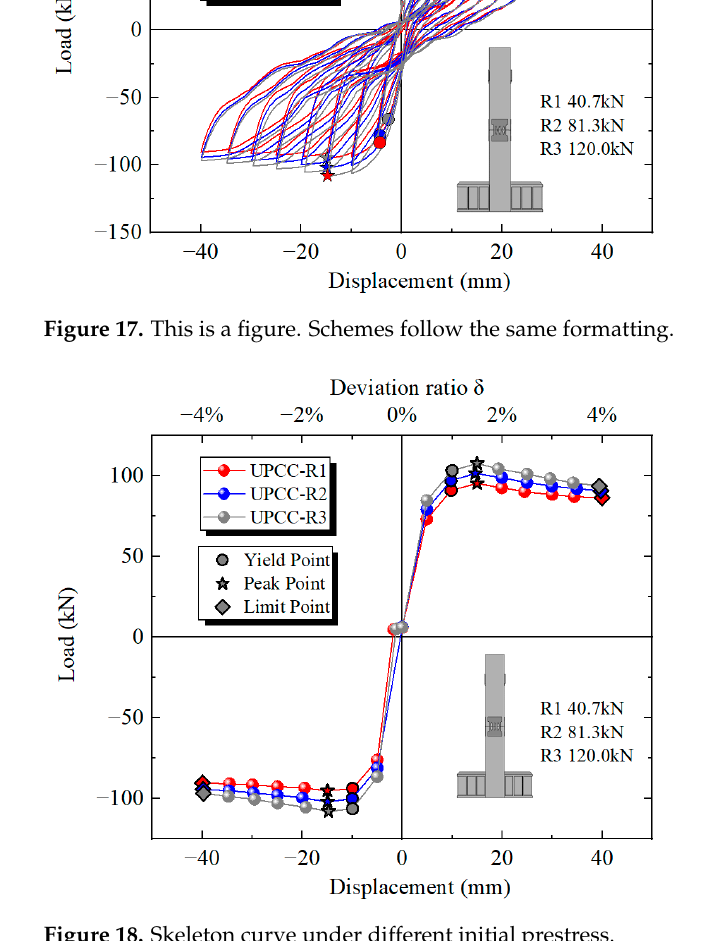
Figure 18. Skeleton curve under different initial prestress.